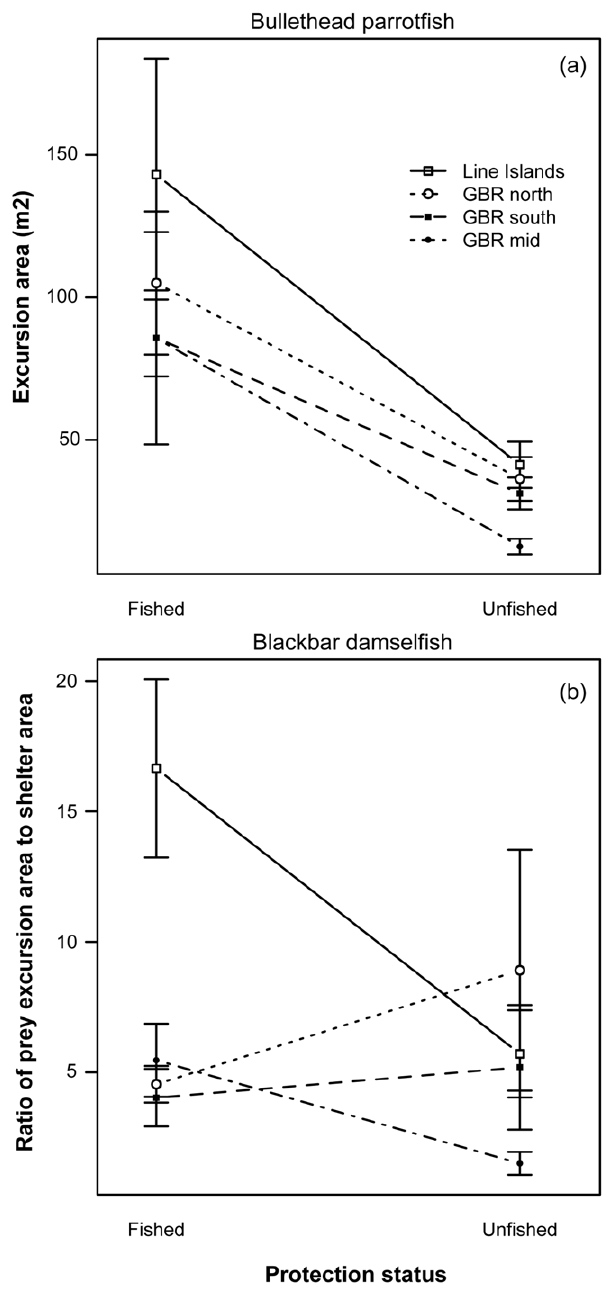
Figure 4. Prey excursion size in relation to protection status. Upper panel (a) is bullethead parrotfish ( C. sordidus ); lower panel (b) is blackbar damselfish ( P. dickii ). Points are means ( 6 SE).